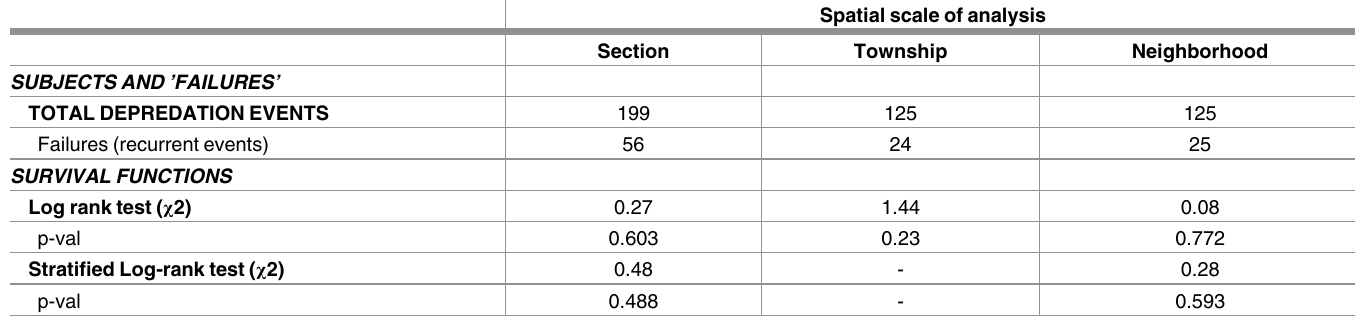
Table 2. General and stratified log-rank ( χ 2 ) tests examining difference between treatments’ (lethal and non-lethal) survival distributions (measur- ing risk of recurrence) after wolf depredations, for all spatial scales.